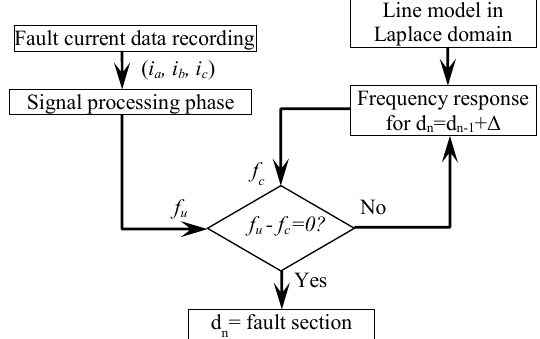
Figure 2. Flowchart of the analytical algorithm based on the analysis of charge transient current waveform.